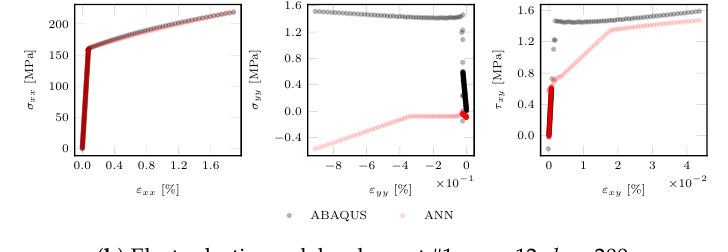
( b ) Elastoplastic model—element #1: m = 12, b = 200.